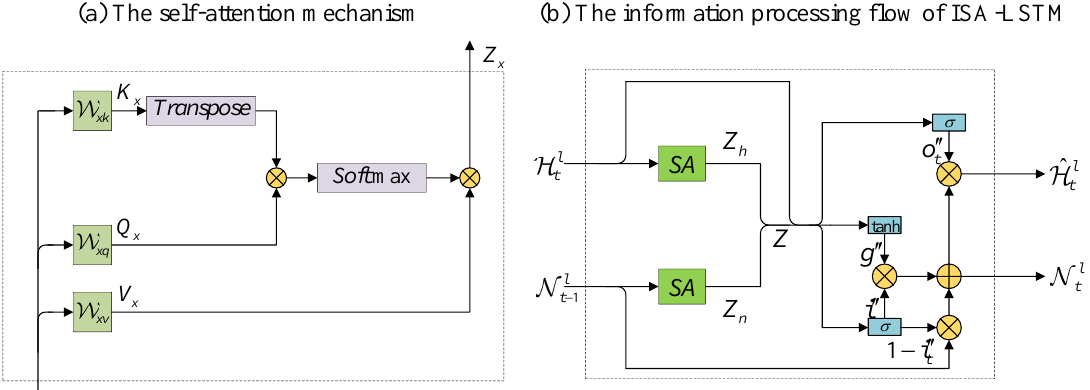
ization feature Z is obtained by aggregating the intermediate features Z h and Z n . i (cid:48)(cid:48) and o (cid:48)(cid:48) are the input gate, input-modulation gate and output gate of the new set of gating t mechanisms. N l and ˆ H l are the final long-term memory states and hidden states. t t